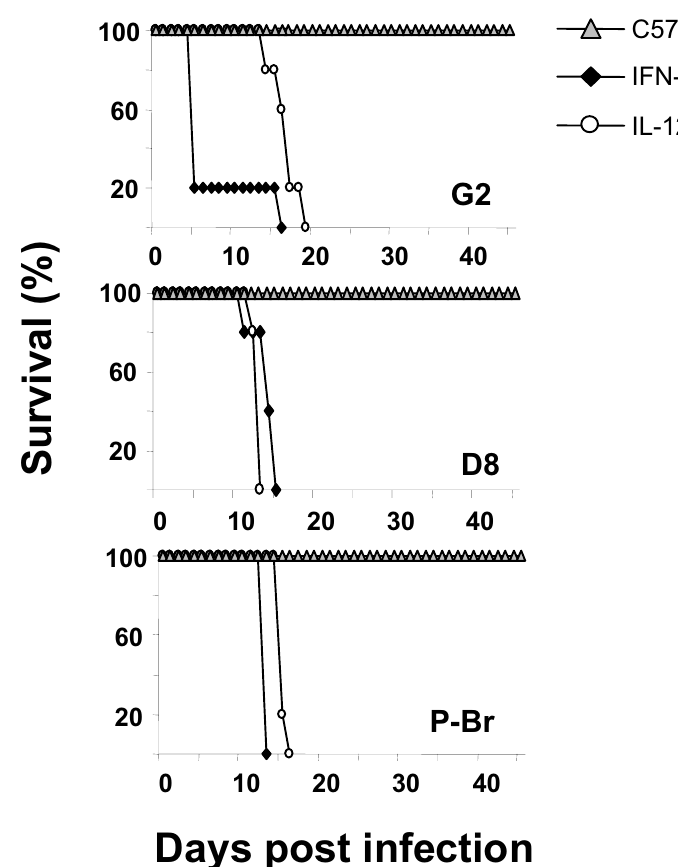
Fig. 2 – Survival of IFN- γ -/-, IL-12-/- and C57BL/6 mice after per-oral infection with 4 cysts of Type I/III strains D8, G2 and P-Br of T. gondii . Data from one representative experiment. Experiment was repeated two times with similar